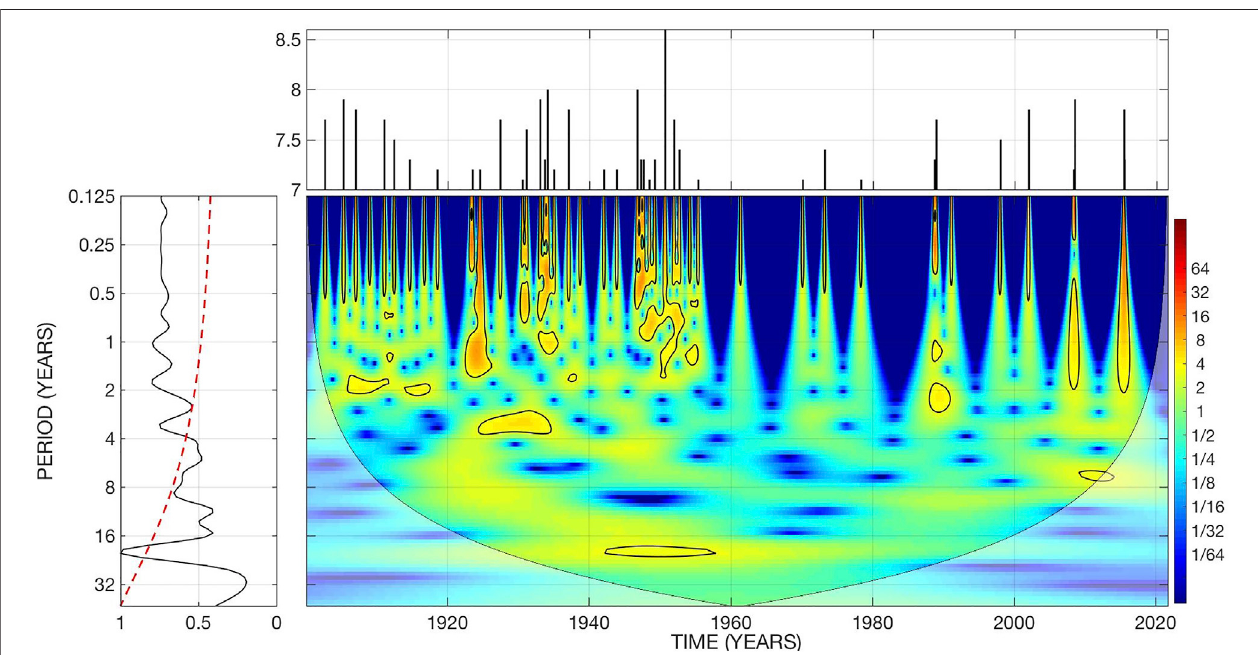
FIGURE13| Resultsofthetime-frequencywaveletspectralanalysisofearthquaketimeseriesrecordfortheSouthernChina-NorthernIndiaseismiczonebetween 1900 and 2021. The global time-averaged wavelet period (left panel) with the red dashed line indicatingthe 95% con fi dence level drawn from a red noise spectrum. The Morlet wavelet power spectral density (MWPSD) in arbitrary units adopting the red-green-blue colour scales (central panel). The cone of in fl uence shows the possible edge effects in the MWPSD (i.e., the U-shaped curves outside of which the spectral information can be considered unreliable).